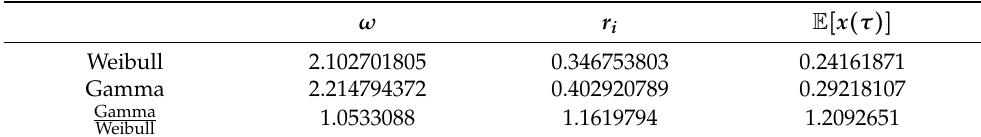
Table 4. Comparison of Bühlmann’s